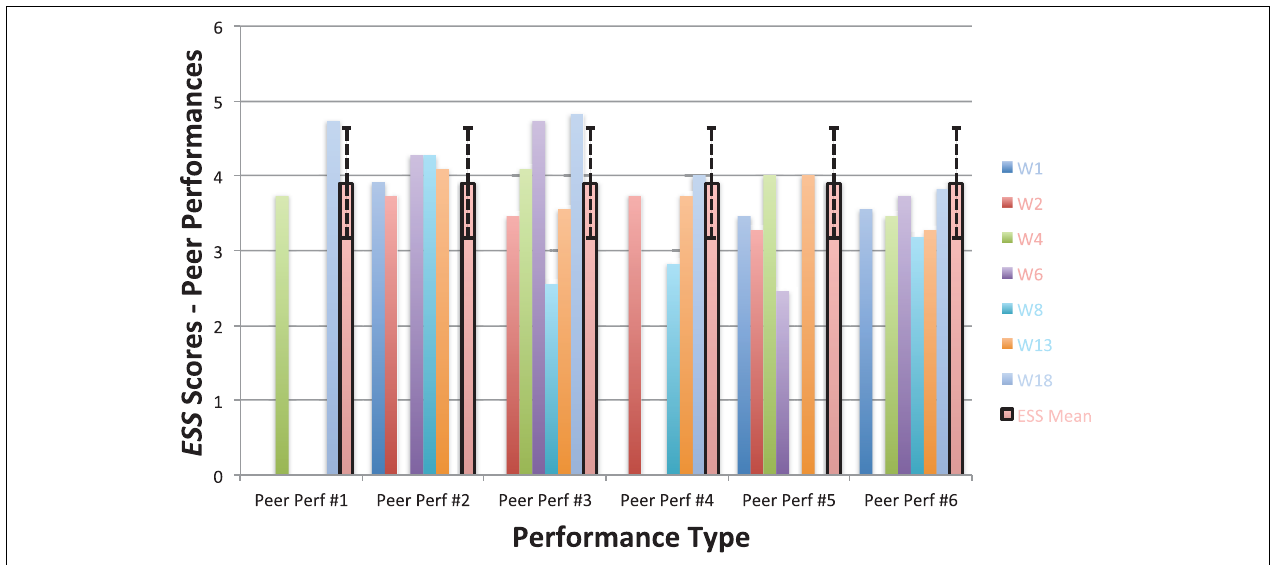
FIGURE 11 | Experiential Shame Scale scores for seven vocal students from six peer performances with piano accompaniment (Juncos et al., 2017), also including the non-clinical mean (3.9) and standard deviation bars ( SD = 0.73; Turner,